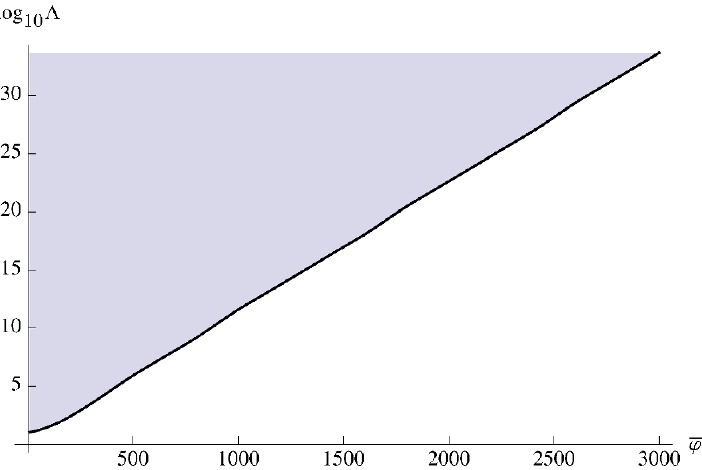
Figure 6 . The unshaded part of the graph is the region of parameter space ((cid:3) ; (cid:22) ’ ) where a (cid:13)at, manifestly stable (i.e. with W B ( ’ 0 ) > 0) solution to the junction condition exists. This graph was obtained numerically using the bulk potential of the form (2.61) with parameters given in equation (2.62), and brane potential of the form